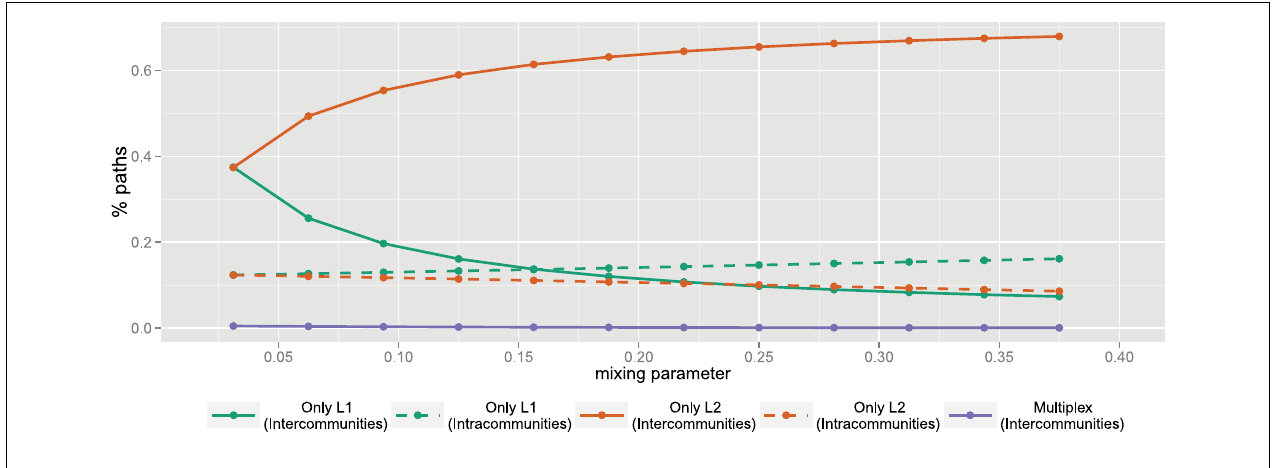
FIGURE 3 | Shortest paths distribution in a multiplex network with community structure as a function of the mixing parameter. The plot shows the fraction of shortest paths that traverse the network using only layer 1 (with fixed topology), using only layer 2 (with varying topology) and using the full multiplex structure. The